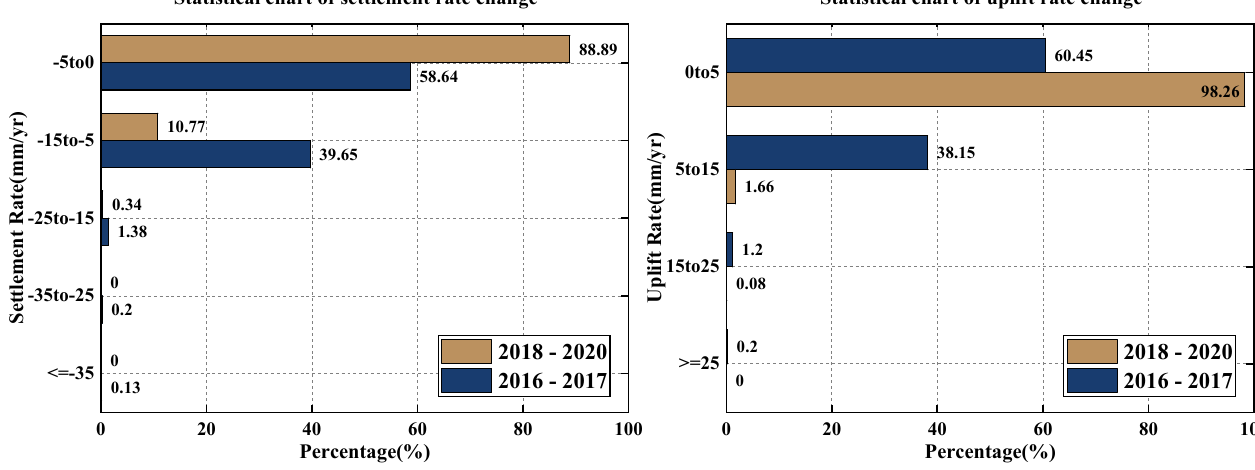
Figure 8. Statistical chart of the change in deformation information in Shanghai region from 2016 to 2020.